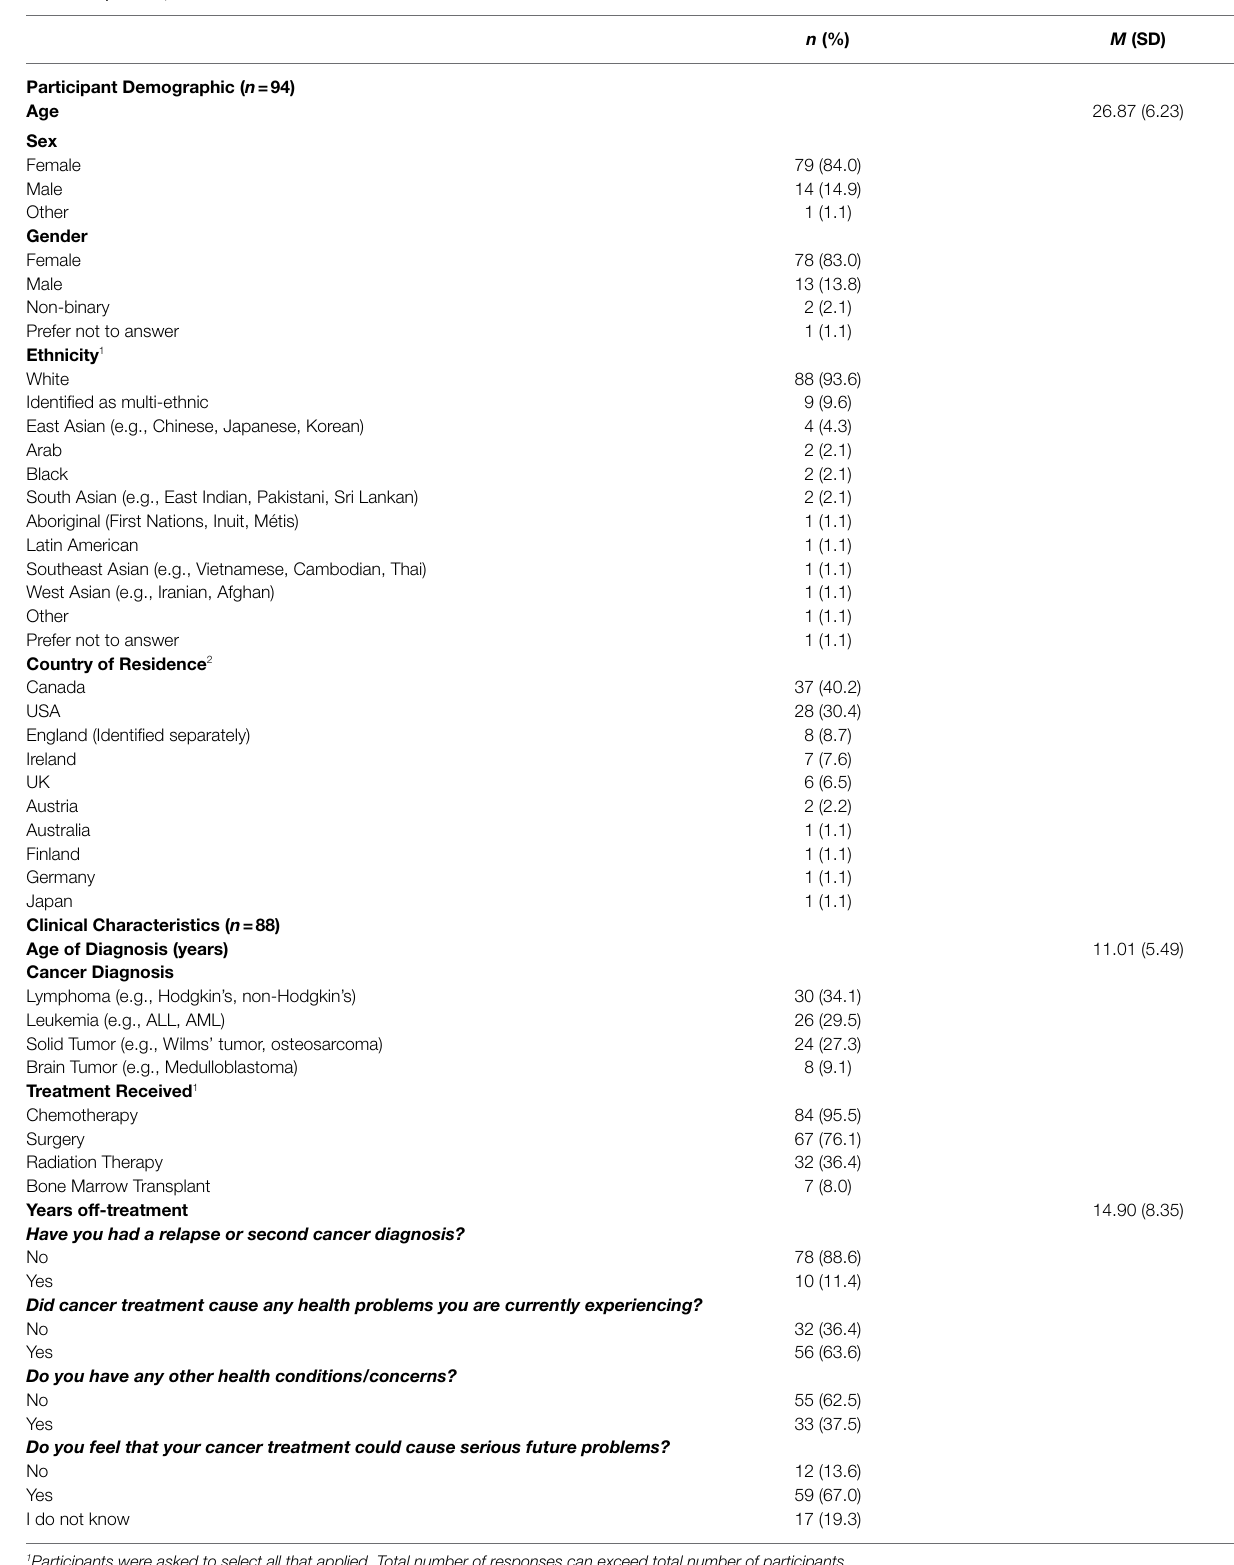
TABLE 1 | Participant and clinical